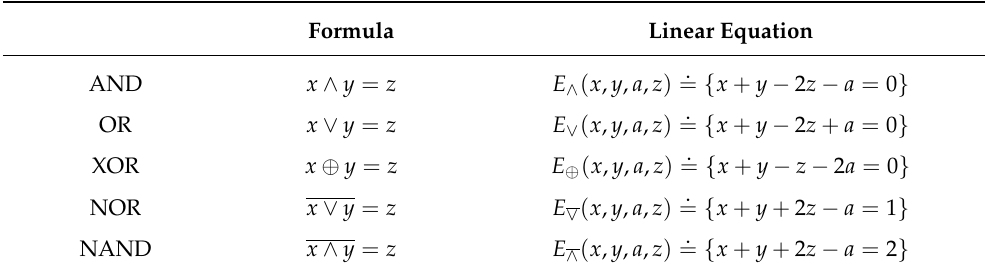
Table 4. Linear equation for elementary operations (linear equations were found in the previous patent; also there was the method for their generation). Formula Linear Equation AND x ∧ y =